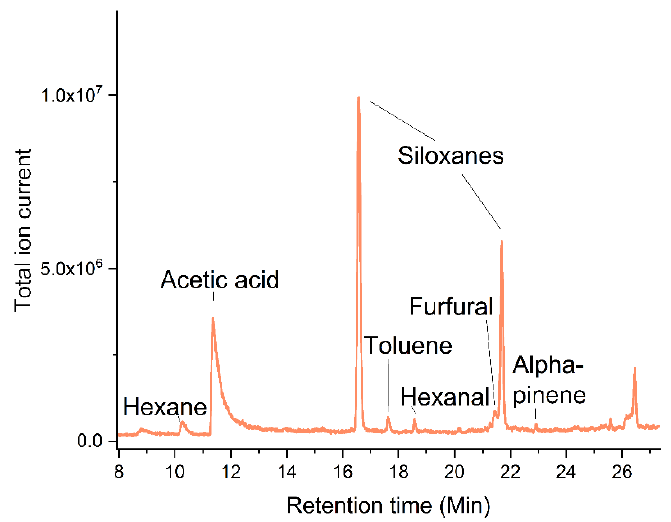
Figure 1. HS-SPME-GC–MS chromatogram of untreated sound wood (sound wood 1). The siloxanes peaks are highly unlikely to be from the sample, but rather a contaminant from the SPME fibre, GC–MS inlet and/or column.